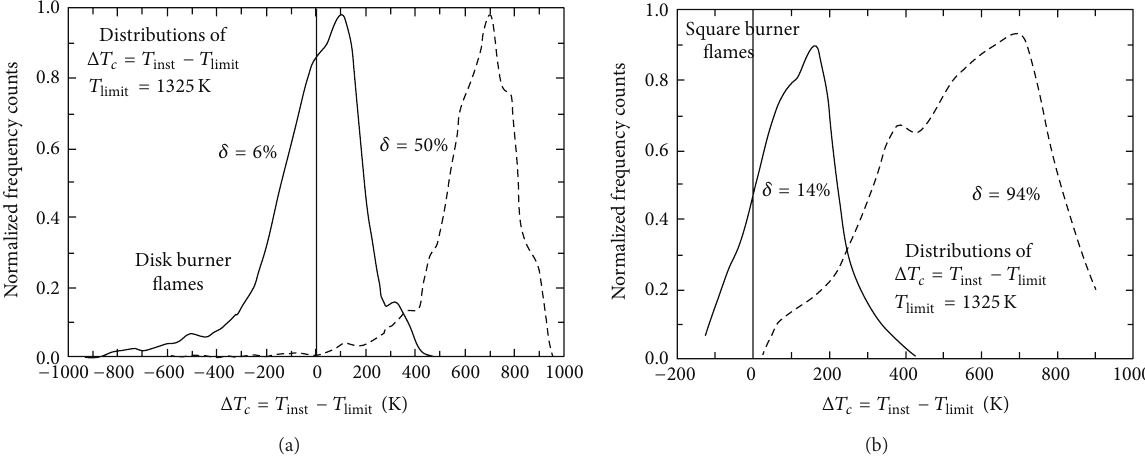
Figure 9: Statistical distributions of the instantaneous temperature difference parameter for the disk (a) and the square (b) at different levels of local